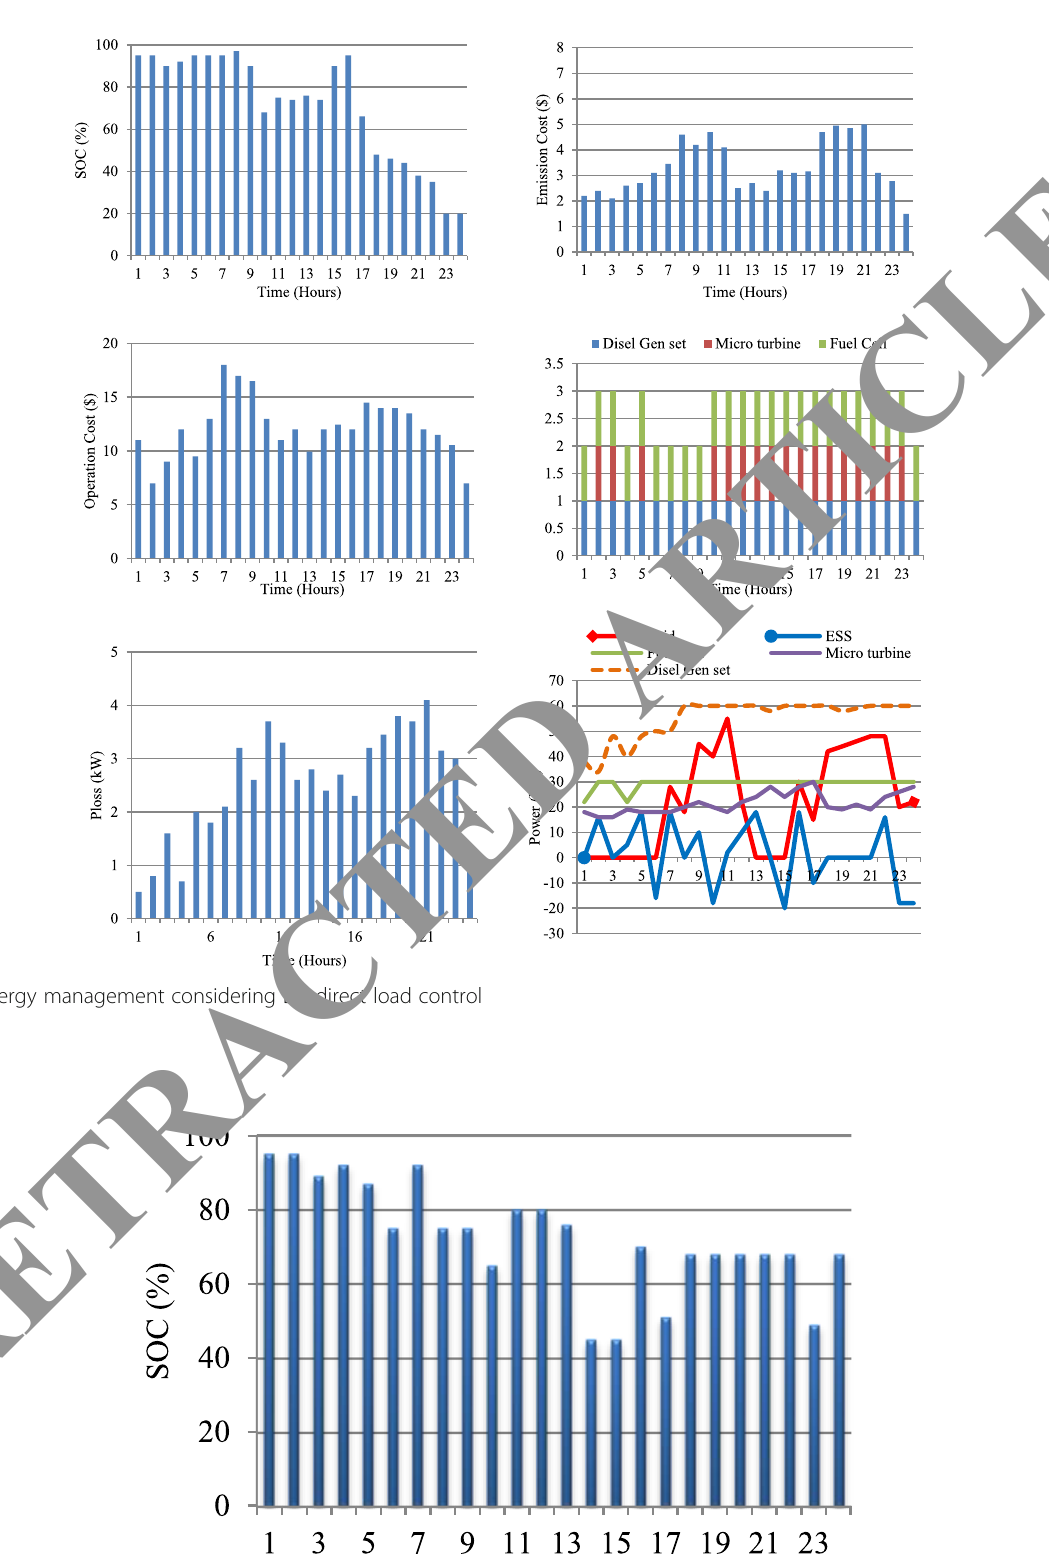
Fig. 9 State of charge of